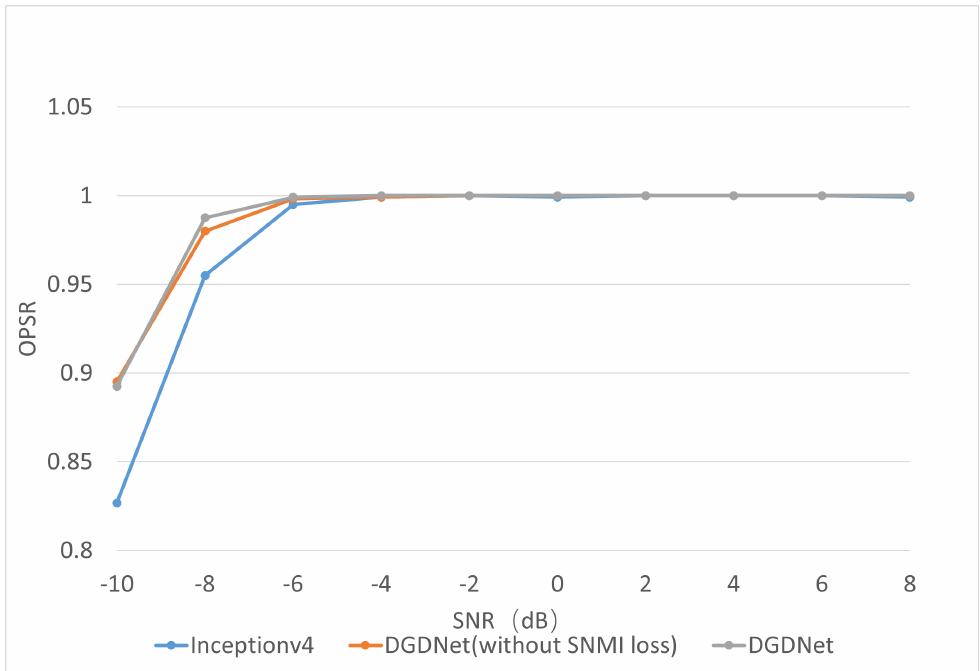
Figure 9. Comparison of the DGDNet with different parameters and Inception_v4 [28]. As can be seen in the figure, Inception_v4’s performance below − 4 dB is inferior to that of DGDNet proposed by us. Meanwhile, DGDNet performed better with